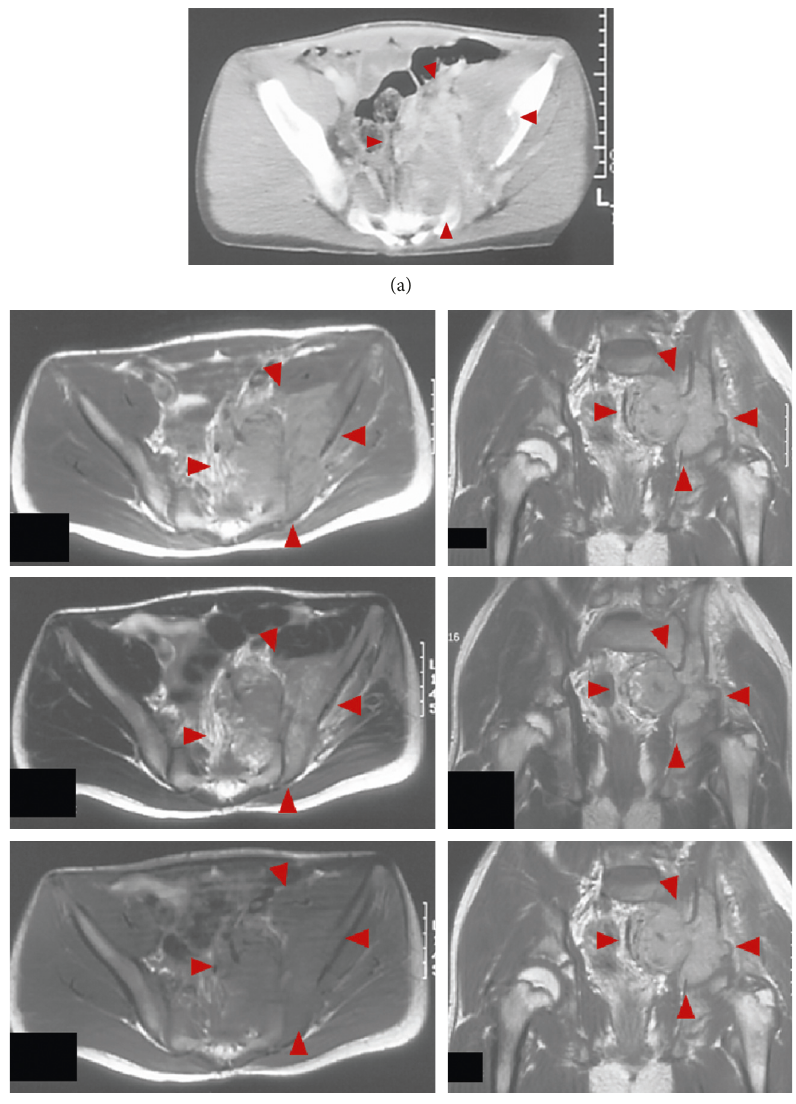
intensity on T1-weighted images and high intensity on T2-weighted images and sparsely enhanced by contrast